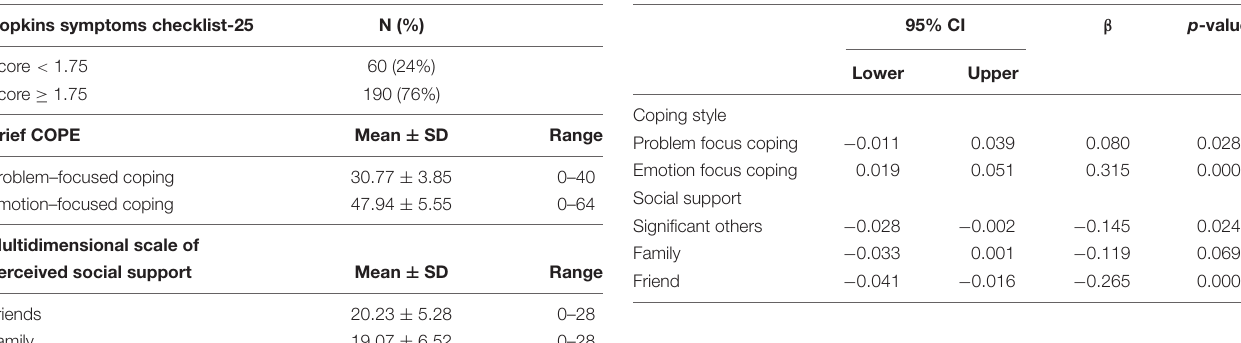
TABLE 3 | Factors predicting high psychological distress in